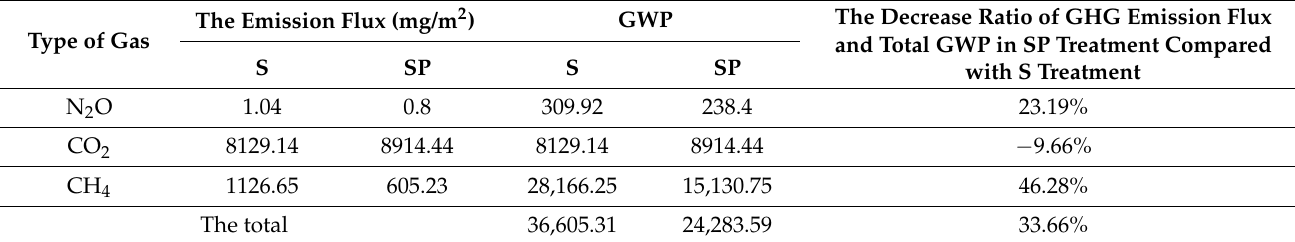
Table 1. 24-h emission flux and change proportion of GHG in each